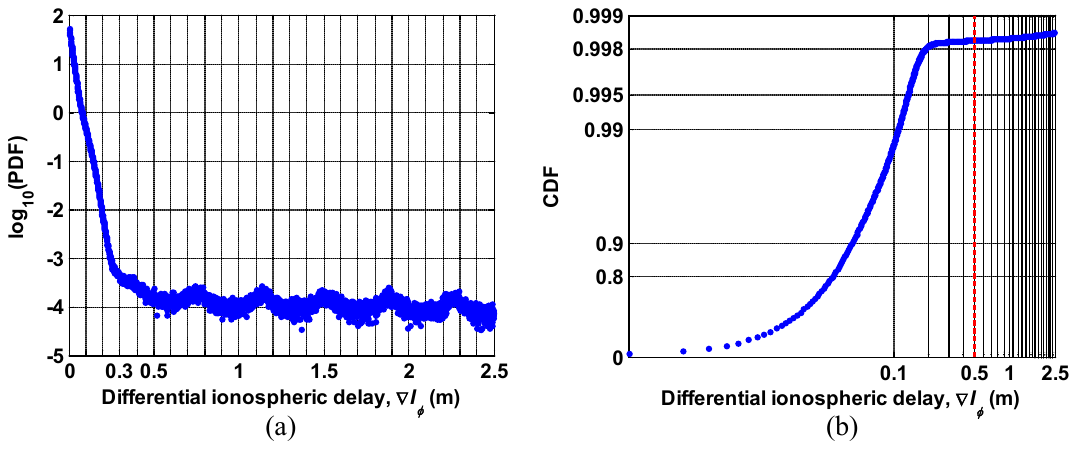
Figure 5. Distribution of differential ionosheric delays, I collected for seven consecutive days: ( a ) probability density function and ( b ) cumulative distribution